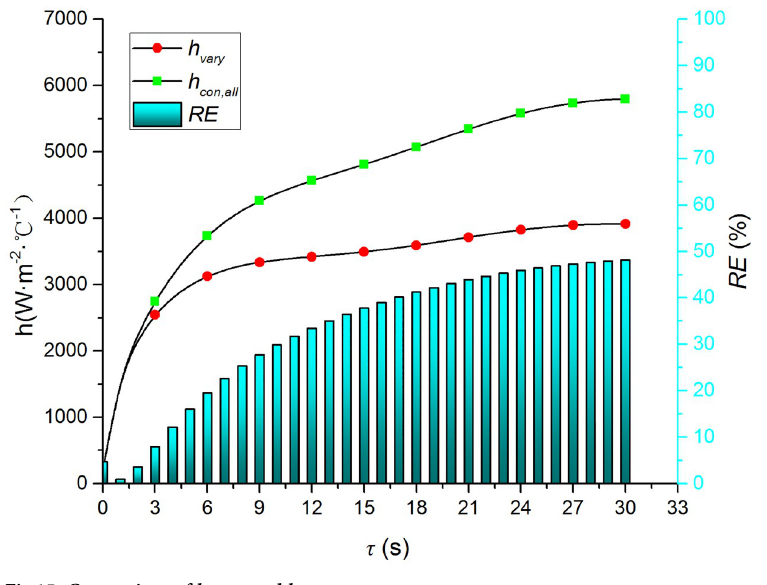
Fig 15. Comparison of h con , all and h var y